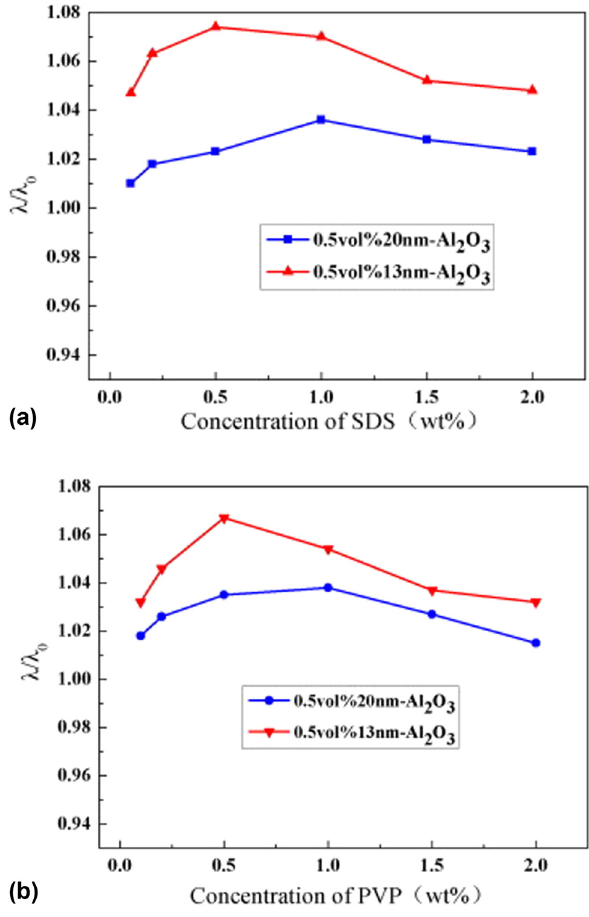
Figure 2: In fl uence of ( a ) SDS and ( b ) PVP concentration on the thermal conductivity of Al 2 O 3 /de - ionized nano fl uids with di ff erent particle size under room temperature [ 41 ]